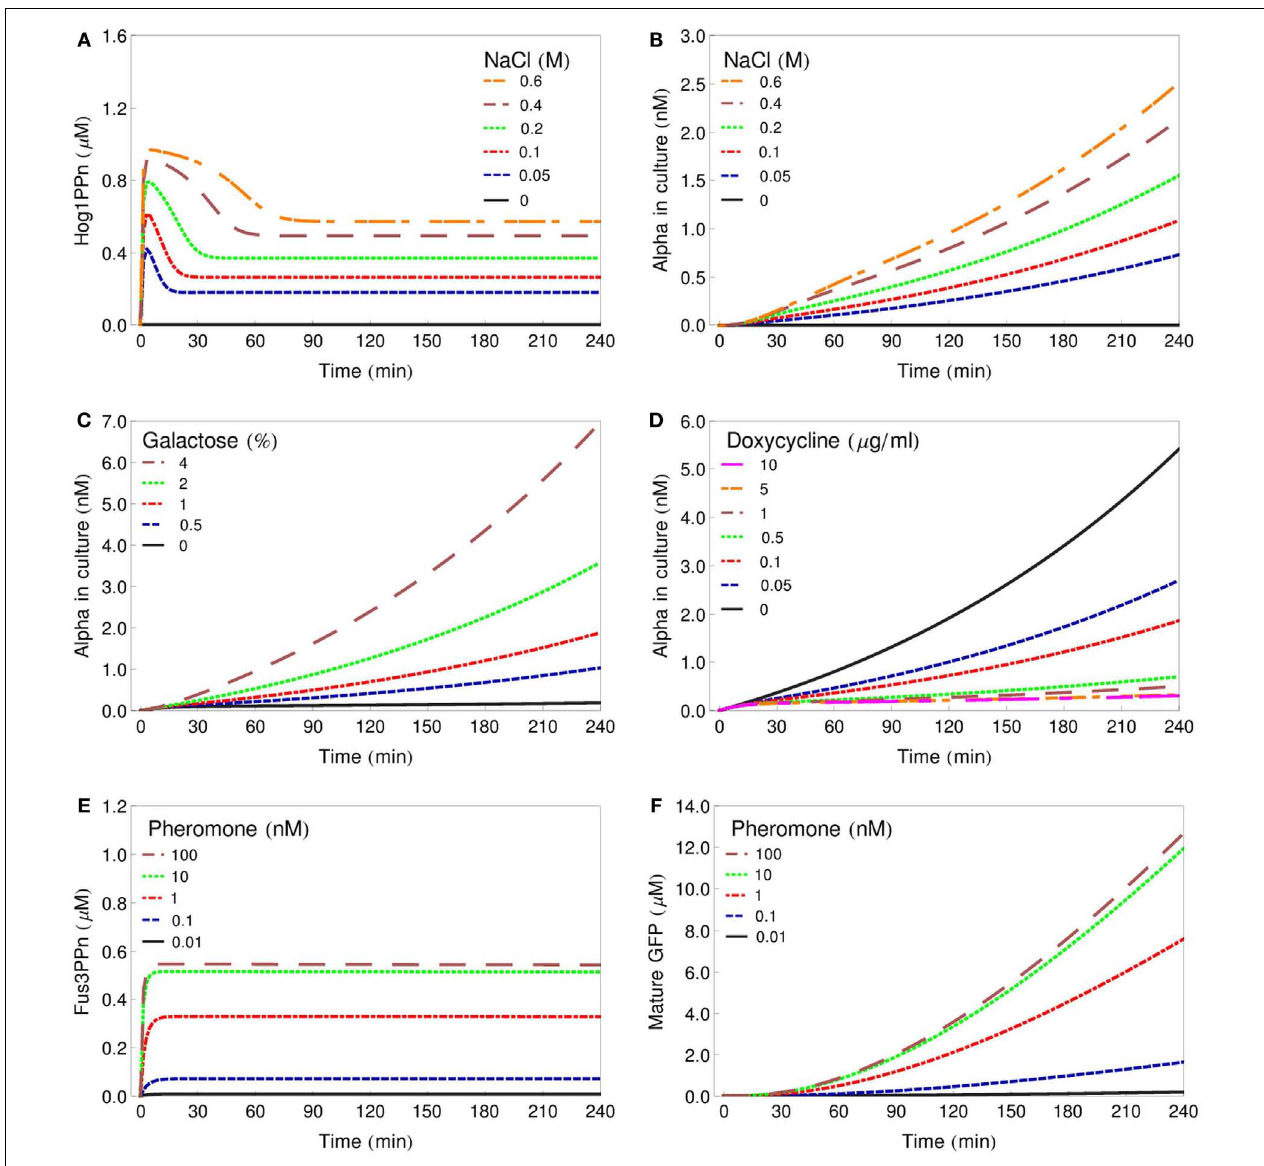
of galactose. (D) Alpha-factor secreted by the dox-cell after treatment with various concentrations of doxycycline. (E) Changes in Fus3ppn concentration after stimulation of the reporter cell with various concentrations of alpha-factor. (F) Changes in the intracellular concentration of GFP in the reporter cell after stimulation with various concentrations of